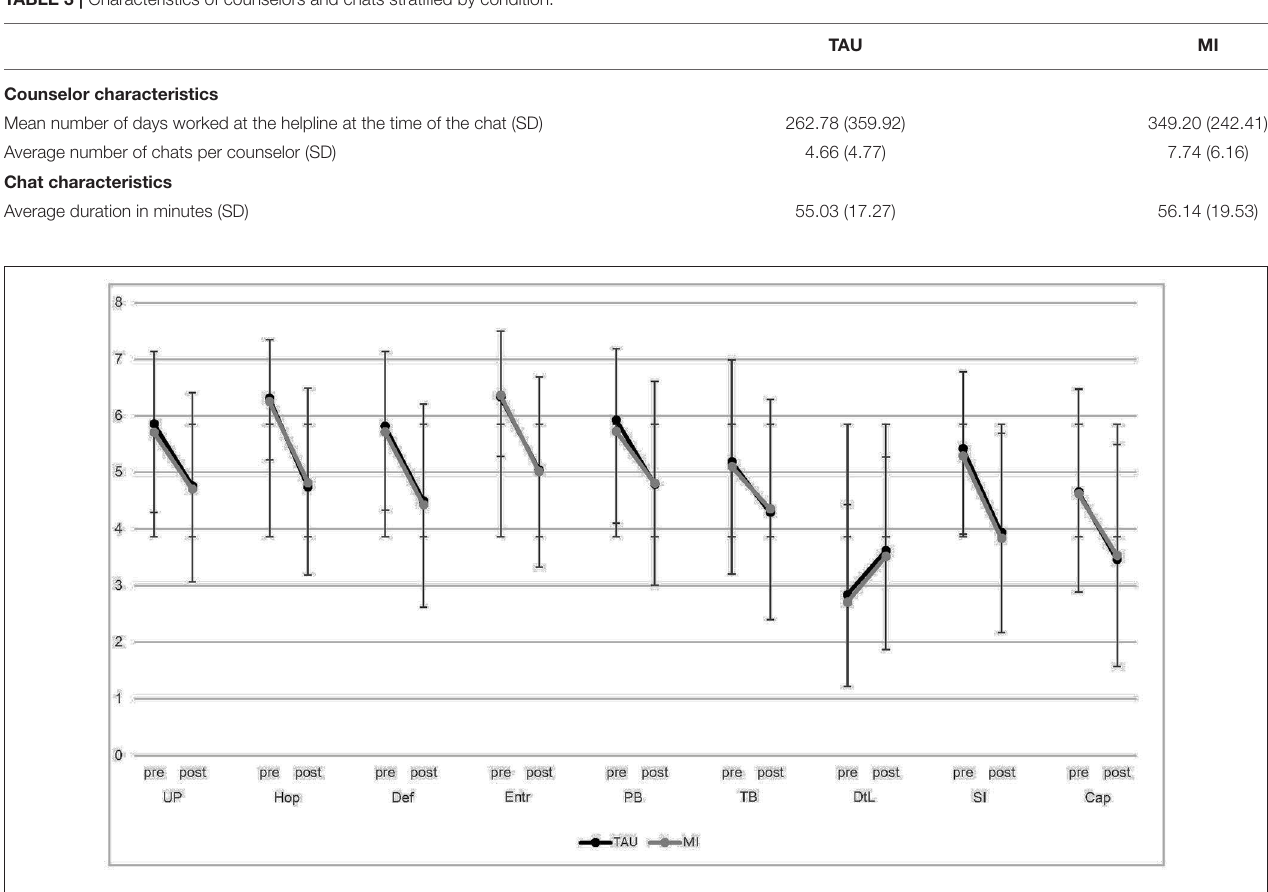
TABLE 3 | Characteristics of counselors and chats stratified by condition.